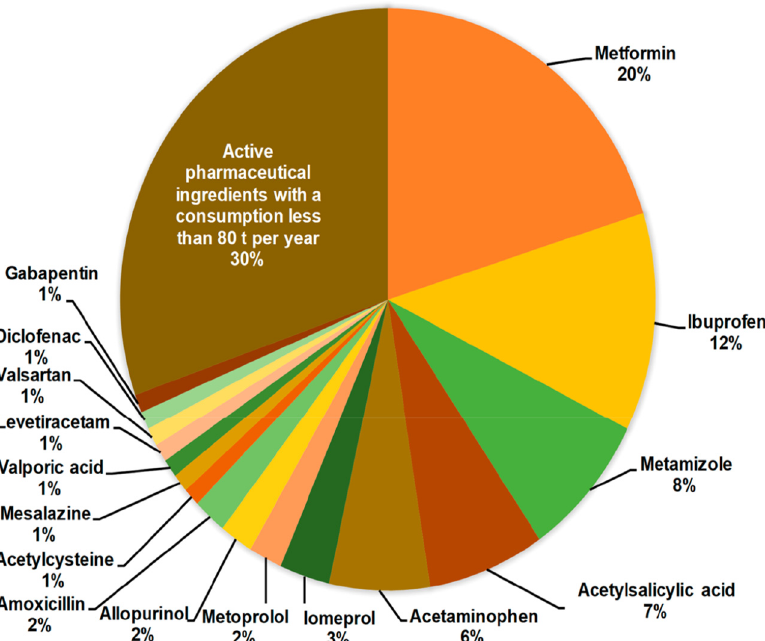
Figure 2. Pie chart showing the patterns of consumption of various pharmaceuticals around the world. Reprinted with permission from [50]. Copyright 2019, American Chemical Society.